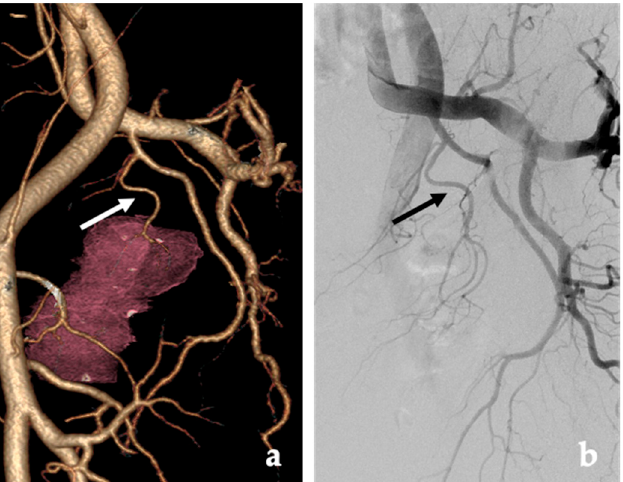
Figure 1. Computed Tomography Angiography (CTA) is useful for PAE procedural planning. ( a ) CTA 3-D reconstruction using the dedicated prostate artery protocol demonstrates the prostate artery origin arising from the internal pudendal artery (white arrow). ( b ) Digital subtraction angiography (DSA) imaging performed at 35 degrees LAO projection shows the prostatic artery arising from the internal pudendal artery (black arrow) correlating with the CTA.